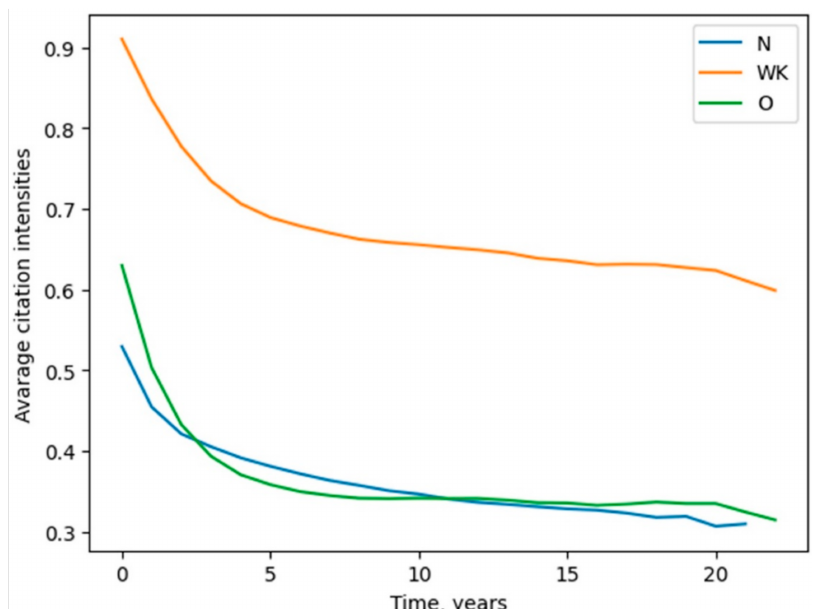
Figure 6. Comparison of average citation intensities of collective subjects belonging to classes N, WK, O, λ =